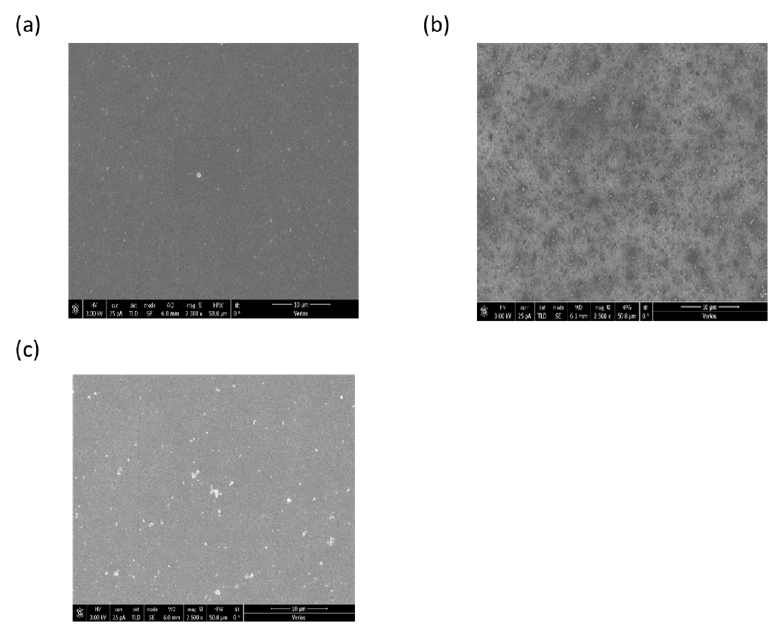
Figure 4. SEM images of the surface of PEDOT: PSS: Au–Ag NPs films with ( a ) PEDOT: PSS with 30 µL NPs; ( b ) PEDOT: PSS with 60 µL NPs; and ( c ) PEDOT: PSS with 90 µL NPs.